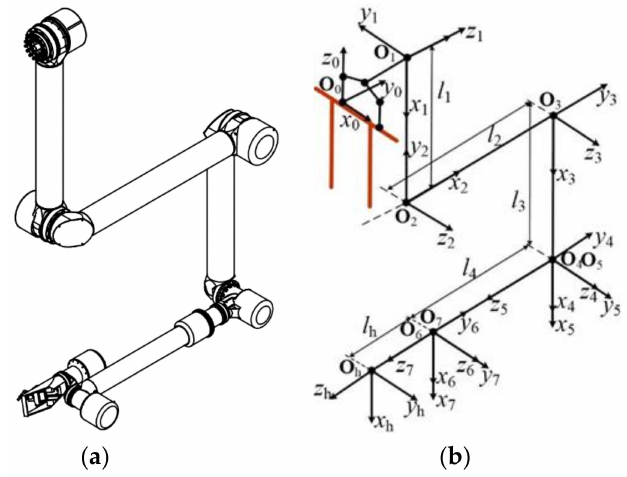
Figure 2. Structure diagram and coordinate systems of the CMBOT. ( a ) Structure diagram of the redundant manipulator. ( b ) The coordinate systems based on the D-H method. Table 1. D-H parameters of the redundant manipulator.